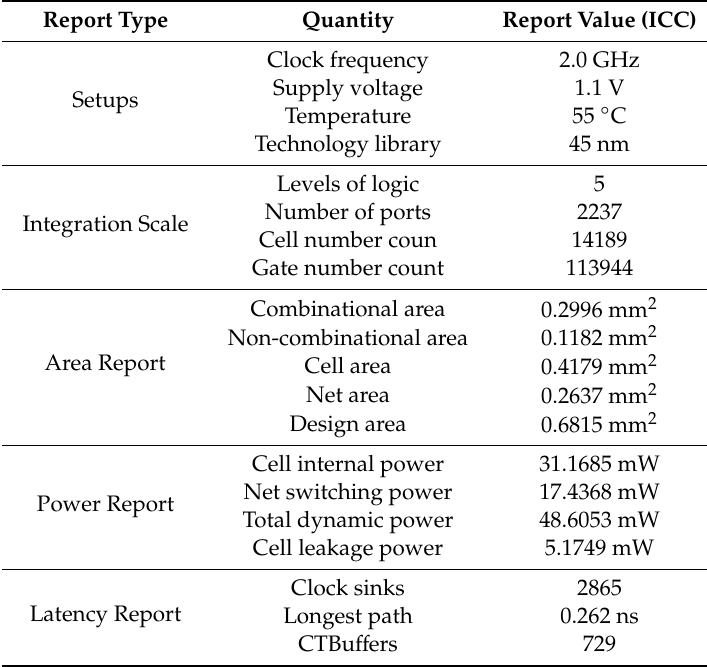
Table 1. Layout reports on integration scale, area and power details 1 .